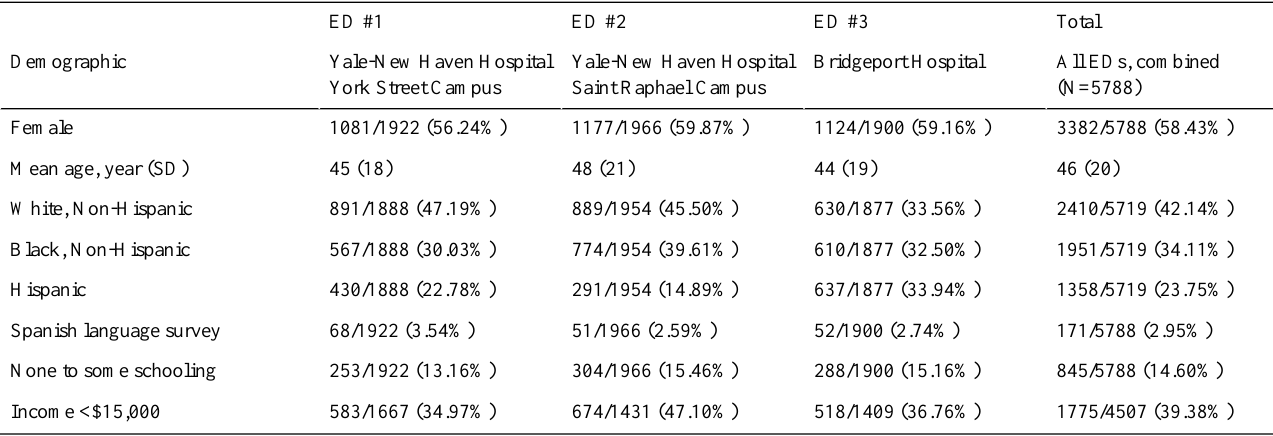
Table 1. Demographic breakdown of 3 emergency departments, July 12 to August 30,